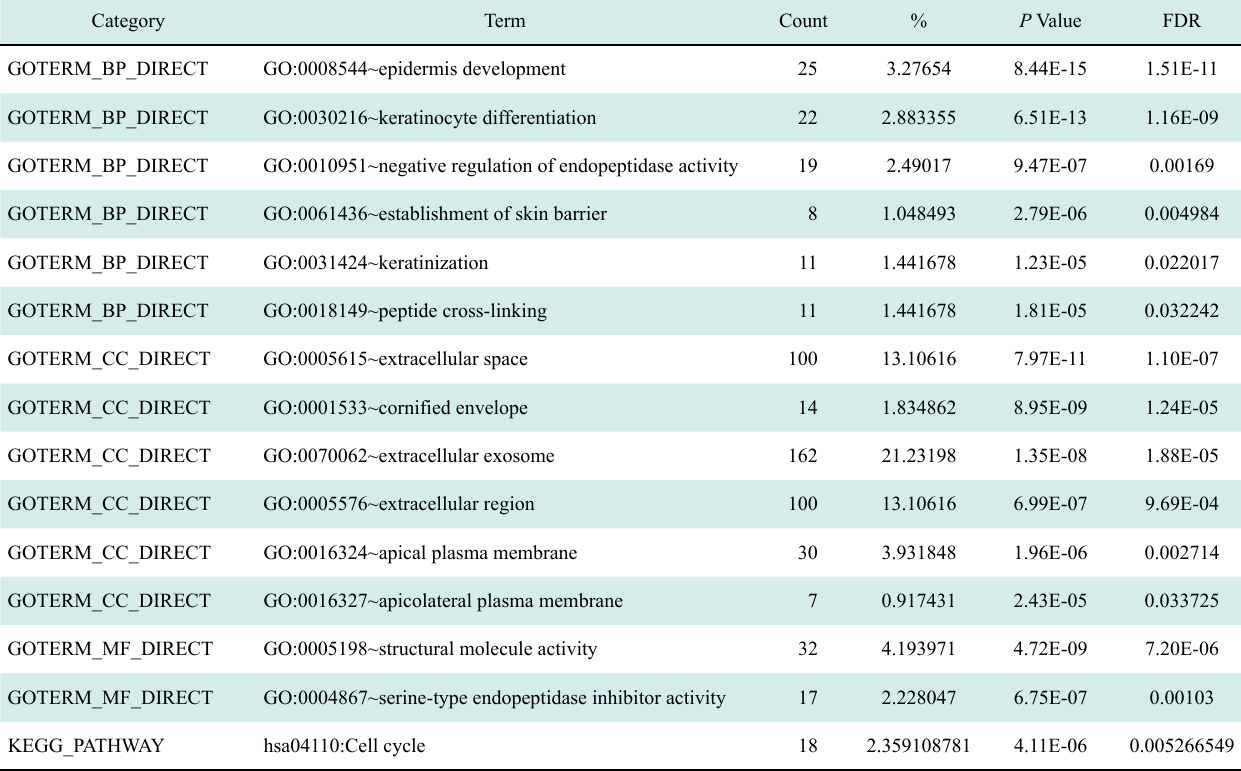
Table 1 GO and KEGG pathways analysis of differentially expressed genes (DEGs) with P < 0.05 Category Term Count % P Value